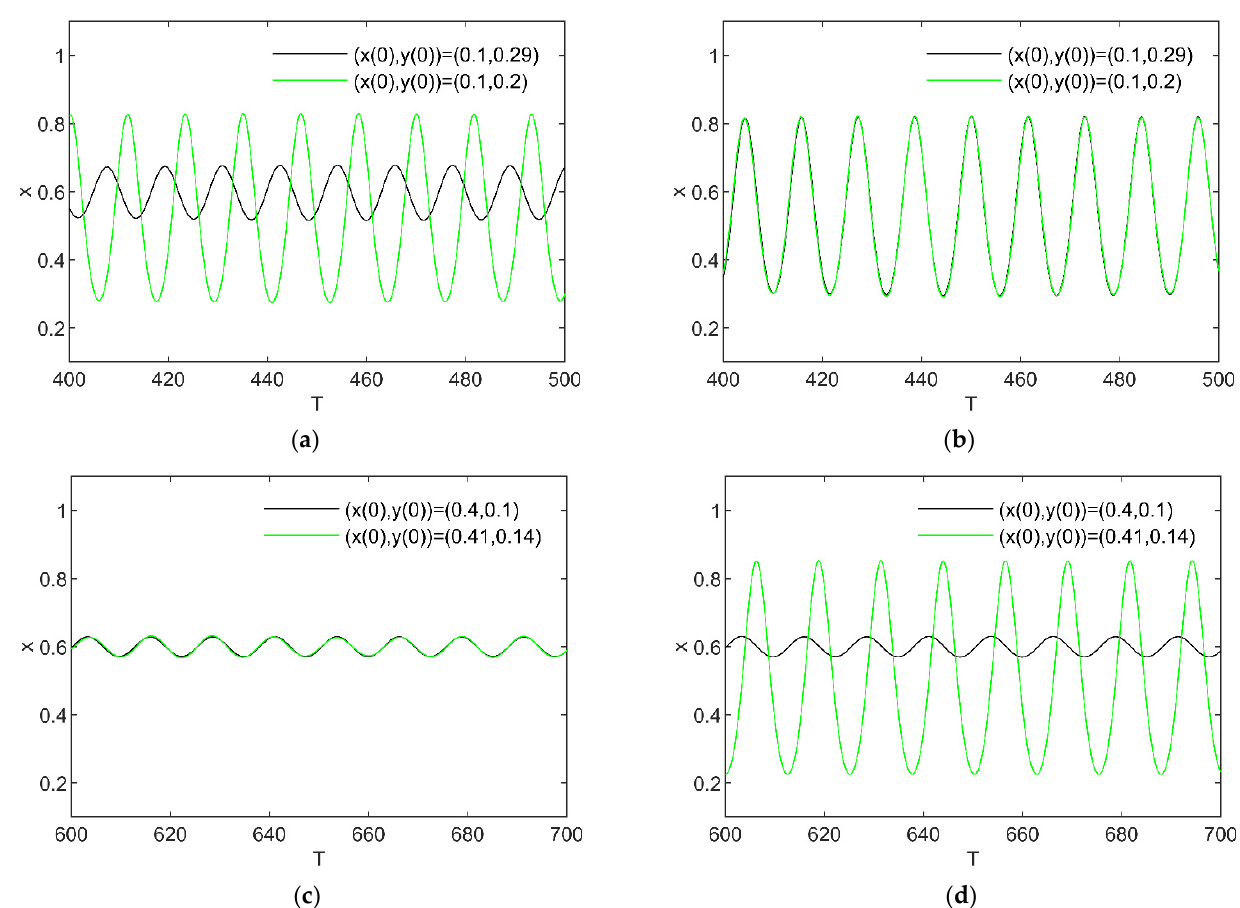
Figure 5. Variation in the time history of the system (3) under perturbations of excitation parameters: ( a ) f 0 = 0.005 and ω = 0.54; ( b ) f 0 = 0.005 and ω = 0.55; ( c ) ω = 0.5 and f 0 = 0.0032; and ( d ) ω = 0.5 and f 0 = 0.0033.